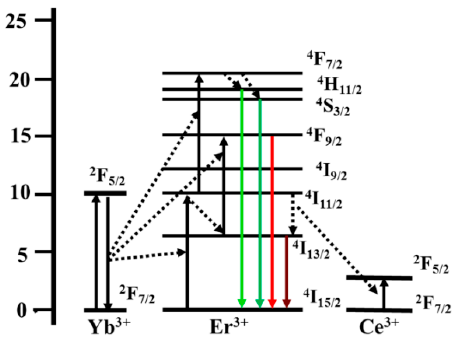
Figure 3. Diagram of energy levels of Yb 3+ -Er 3+ -Ce 3+ and up-conversion (UC) emission and down-conversion (DC) emission processes in the BaLuF 5 :Yb 3+ ,Er 3+ ,Ce 3+ systems under 980 nm excitation.